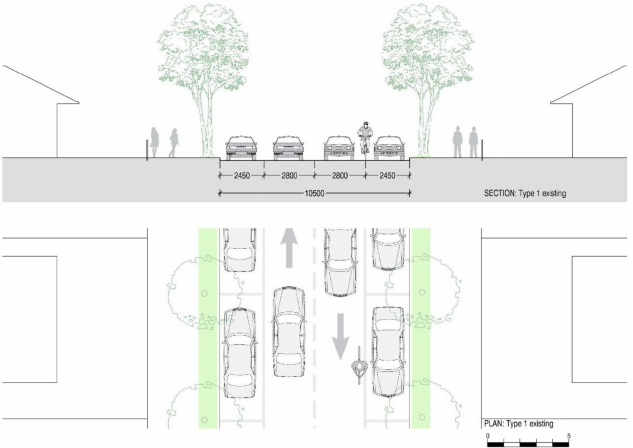
Figure 3. Section and plan drawings showing ‘Type 1 (cid:48) existing street configuration with between 10.5 m and 11.5 m street roadway width, 2.45 m parking spaces on either side of the streets and two-way single traffic lanes of 2.6 m width to accommodate 50–60 km/h s speed limit. The road elements of the new design contain a one-directional cycling lane, barrier, two traffic lanes in opposite directions and two parking lanes. This reconfiguration allows cyclists to ride safely in a single direction. This design has to be matched with a corre- sponding road that includes a cycling lane in the opposite direction. Design 1A contains a one-way cycling lane on the left side of the street along with existing street elements in Type 1 streets. In contrast to design 1A, design 1B contains one-way cycling on the right side of the street to provide access to the opposite direction in the road network. Figures 4 and 5 display new street designs (Design 1A and Design 1B) with a one-directional cycling lane for Type 1 streets.